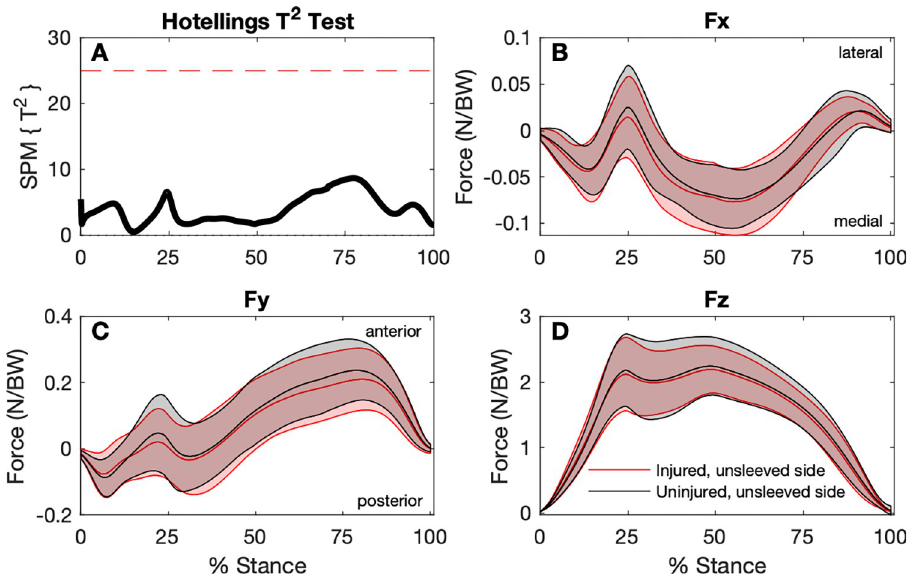
Fig 2. Comparison of ground reaction forces during the stance phase of the step-down hop for the injured (unsleeved) sides to the uninjured contralateral sides (n = 30). A: SPM Hotellings T 2 test trajectory, dashed red line indicates adjusted significance criterion; B to D: x (lateral/medial), y (anterior/posterior), and z (vertical) component curves (mean and ± 1 standard deviation bands),